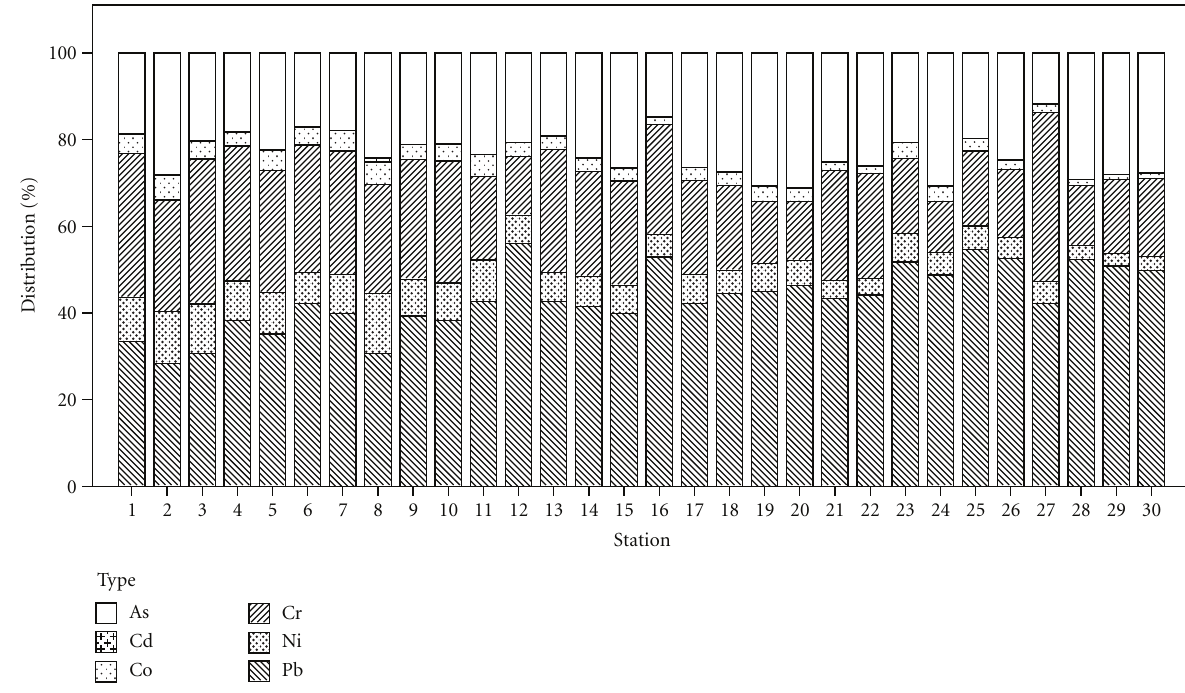
Figure 5: Distribution of metals in sediment samples from 30 sampling stations at Langat River.